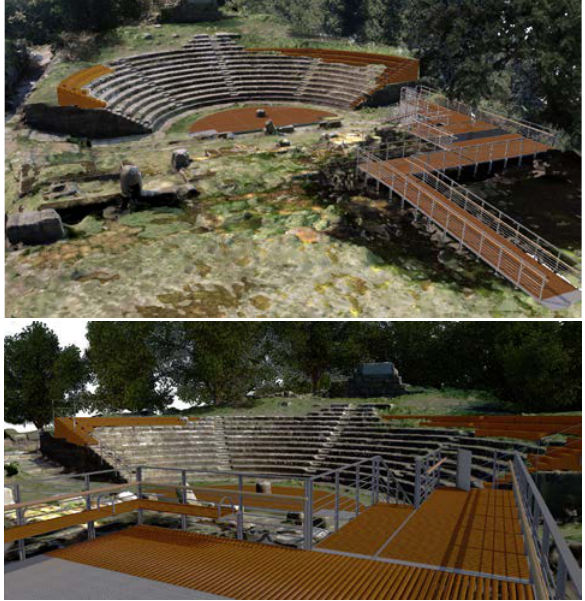
Figure 11. Some render obtained by integrating the survey mesh model and the solid design